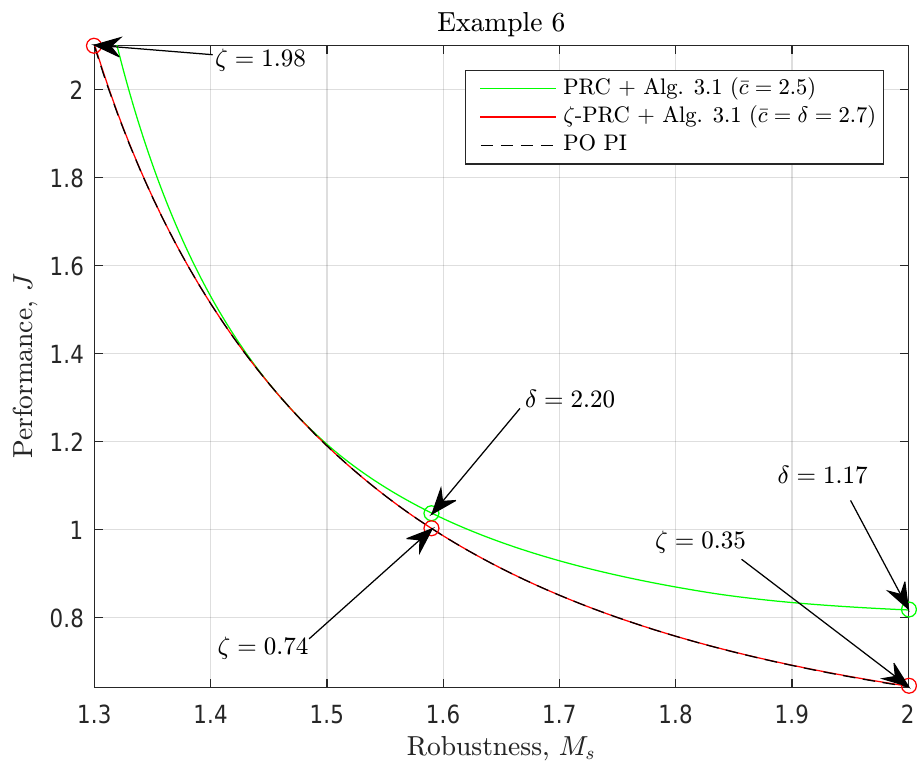
Figure 12. Example 6. PI control of the higher order underdamped process model (Equation